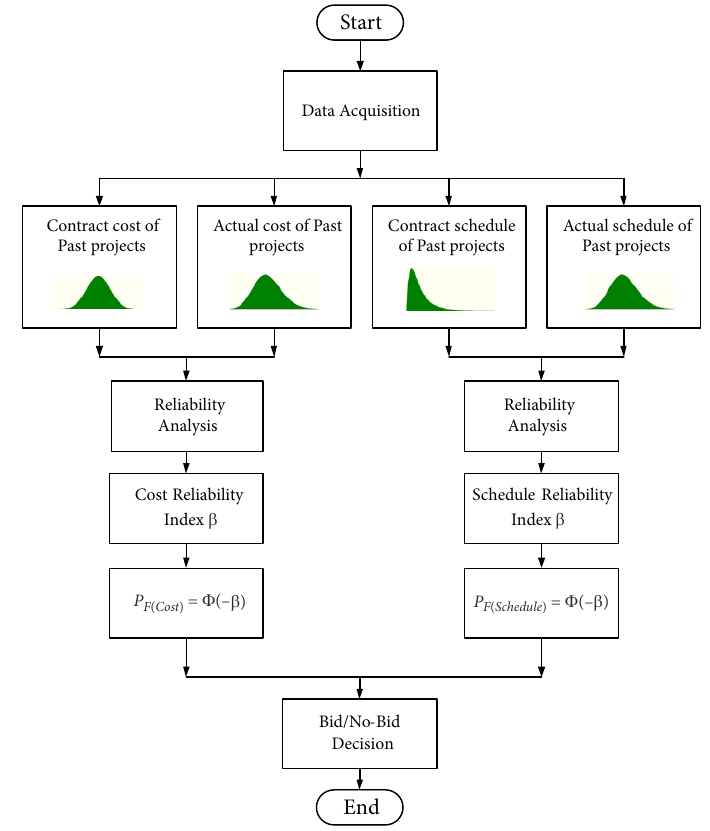
Figure 3. Bid/no-bid decision making based on reliability analysis